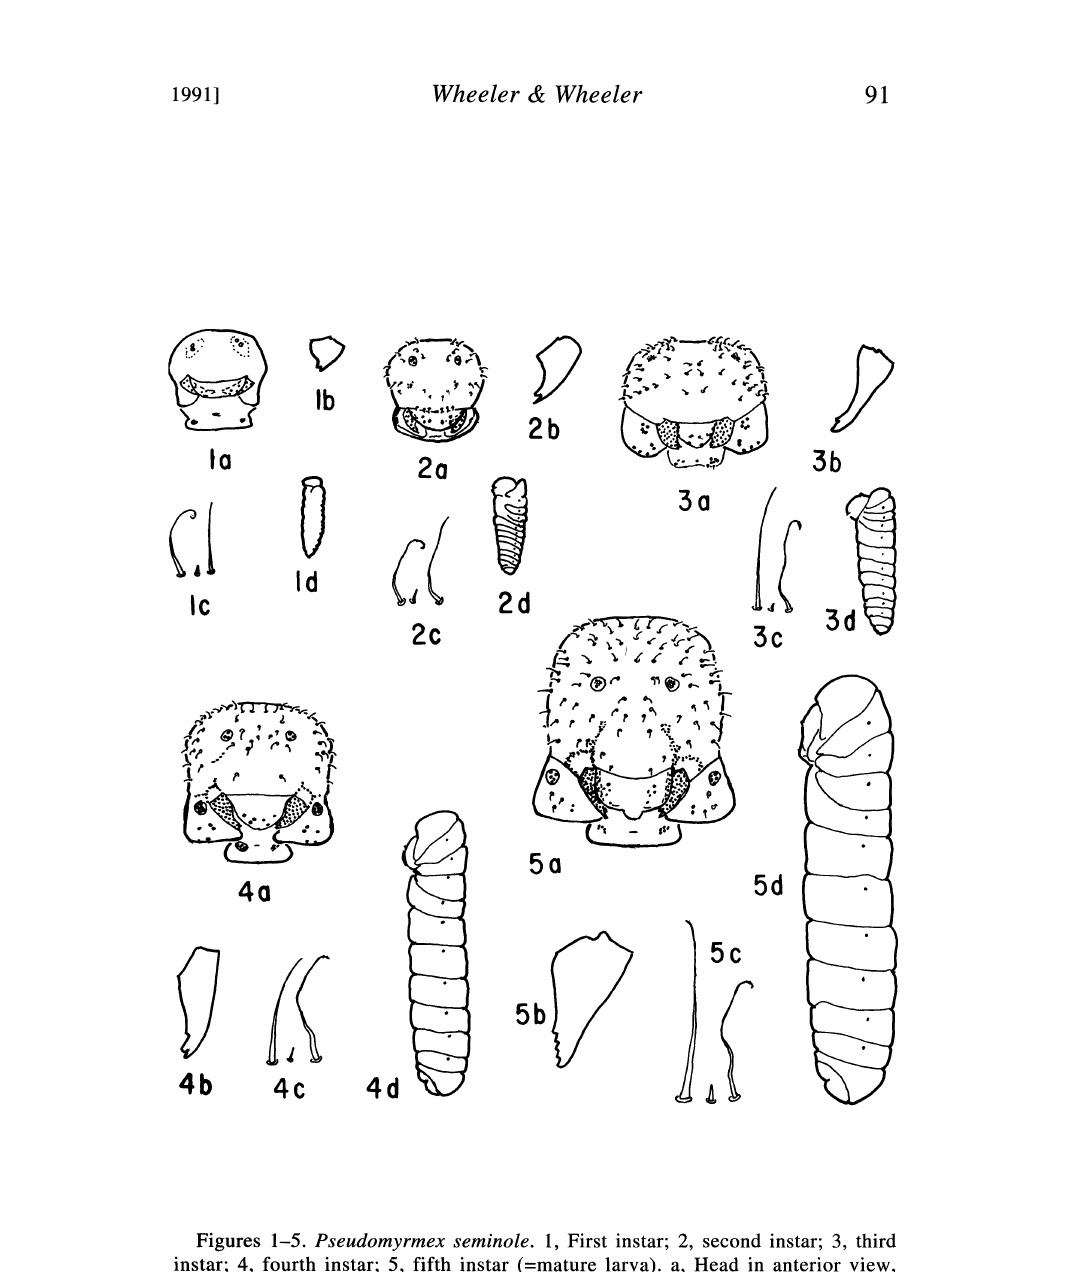
Figures 1-5. Pseudomyrmex seminole. 1, First instar; 2, second instar; 3, third instar; 4, fourth instar; 5, fifth instar (=mature larva), a, Head in anterior view, 60; b, left mandible in anterior view, 130; c, body hairs, 100; d, larva in side view (hairs omitted),